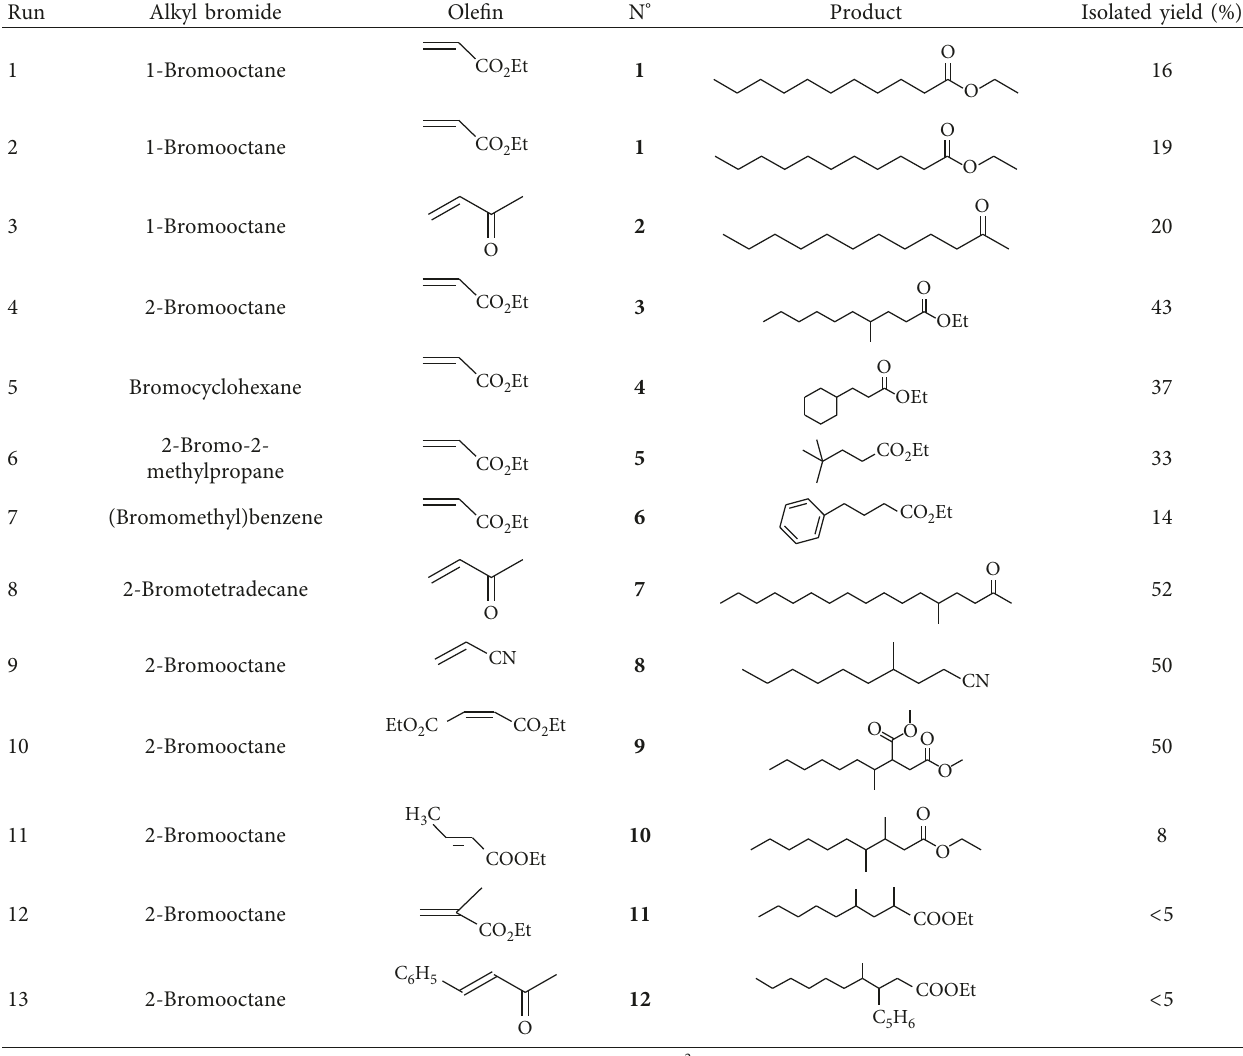
Table 6: Electroreductive alkylation of activated olefins electrocatalyzed by cobalt-Salen in an undivided cell with an iron anode. Run Alkyl